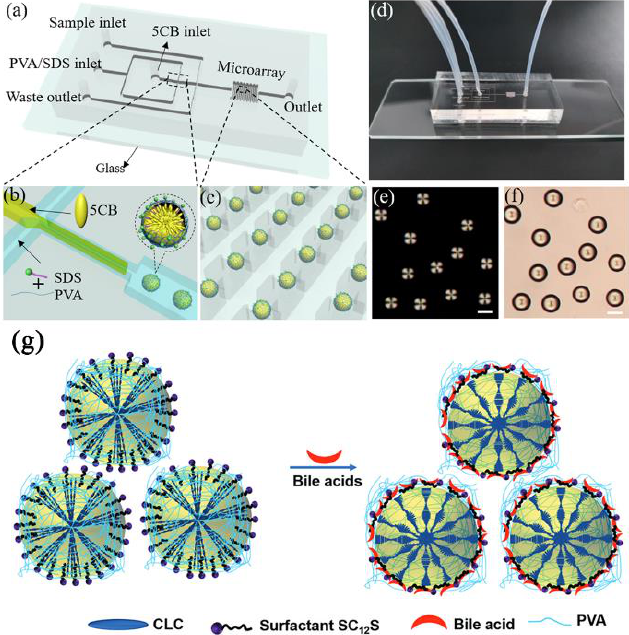
Figure 4. Schematic illustration of ( a ) the microchip to generate monodisperse 5CB droplets, ( b ) flow-focusing element, and ( c ) entrapment of the 5CB droplets in the microstructure. ( d ) Photograph of the microchip. ( e ) The POM and ( f ) bright-field images of the 5CB droplets. Reprinted with permission from ref. [74]. Copyright 2020 Elsevier. The scale bar is 50 µm. ( g ) Schematic illustration of the director configuration transition of PVA/SC 12 S-stabilized CLC droplets from homeotropic to planar, triggered by surfactant – bile acid interactions at the surface of the dispersed CLC droplets. Reprinted with permission from ref. [86]. Copyright 2021 Royal Society of Chemistry.